Question: Give a one-sentence summary of this figure.
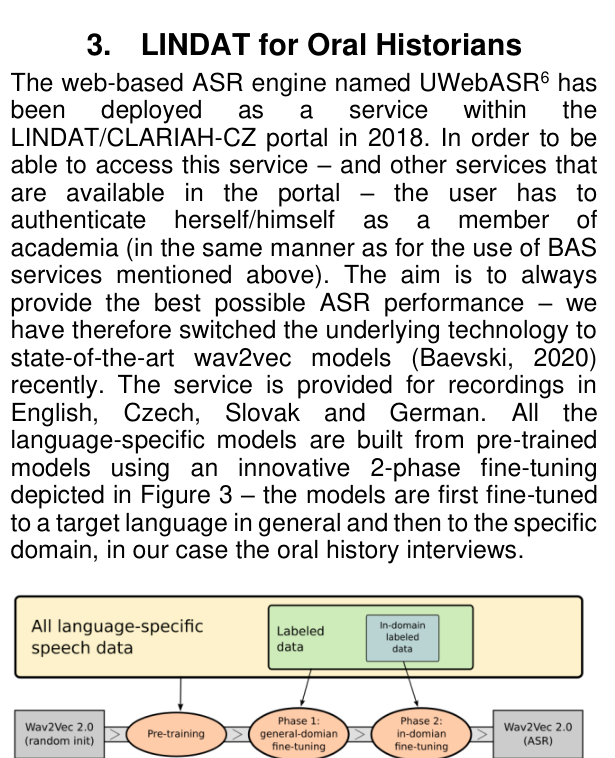
Answer: The scheme of 2-phase fine-tuning      The fine-tuning procedure was the same for all the  languages, one of the key differences is in the choice  of pre-trained model. For English, the model from  Meta AI (wav2vec2-base) was used. For Czech and  German, we have pre-trained our own model from  scratch. The Czech model named ClTRUS7 was then